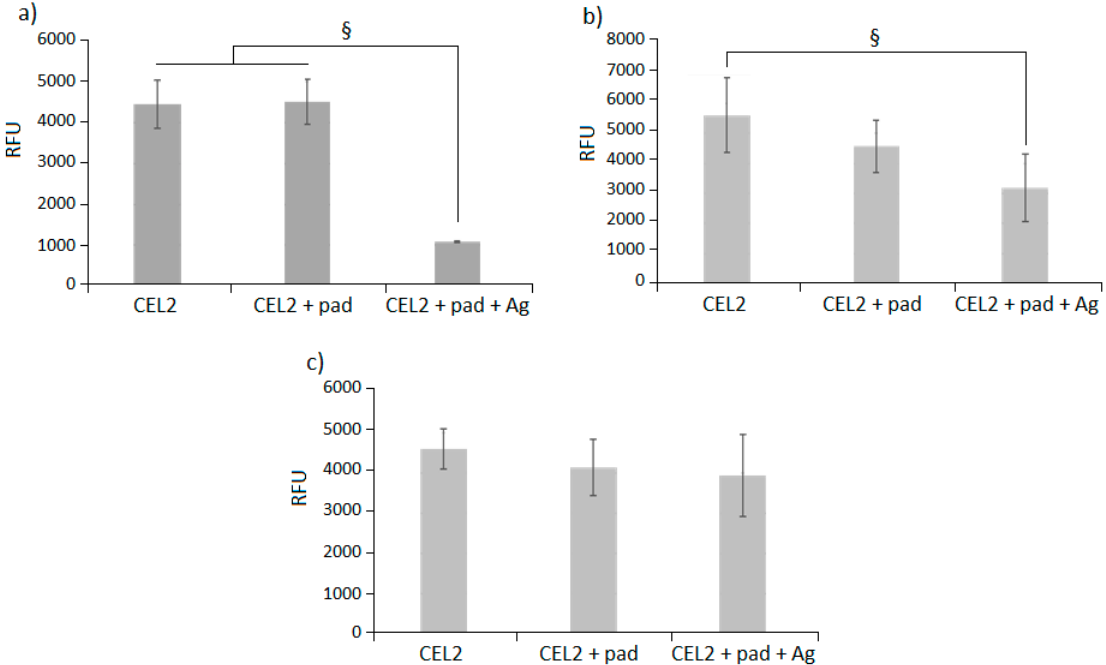
Figure 5. Specimens’ antibacterial activity in direct contact with S. aureus biofilm for ( a ) 24, ( b ) 48, and ( c ) 72 h. The doping with algae extract only (CEL2 + pad) was not e ff ective at decreasing bacteria viability ( p > 0.05) in comparison with untreated controls (CEL2). The introduction of silver in combination with extract (CEL2 + pad + Ag) produced a decrease in bacteria metabolism that was significant after 24 and 48 h of cultivation (c, p < 0.05, indicated by the §) in comparison to both CEL2 and CEL2 + pad. The e ff ect decreased after 72 h, probably due to saturation. Bars represent means and standard deviations; data are expressed as